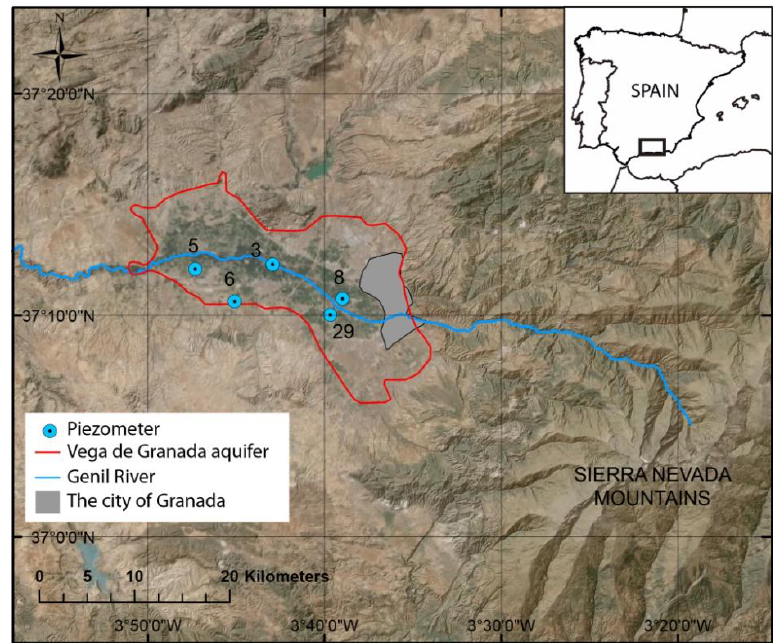
Figure 1. Location of the case study. The Vega de Granada aquifer is of regional importance. It is located within the Granada Basin domain (southern Spain) and in the central sector of the Betic cordillera (Sierra Nevada).